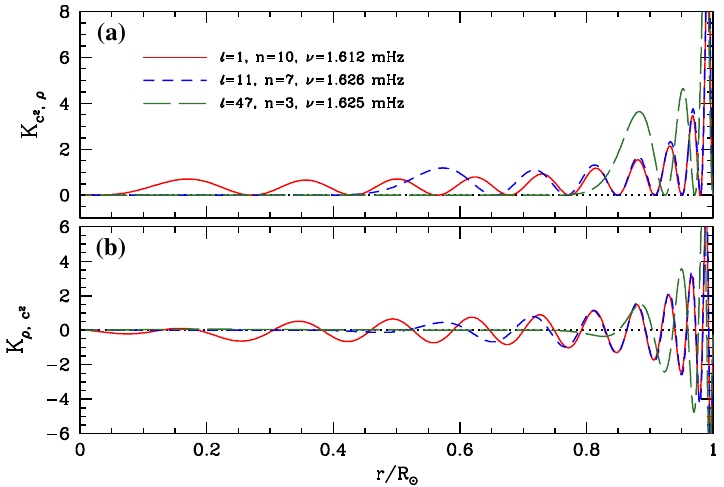
Fig. 11 Sound-speed kernels ( a ) and density ( b ) for modes of different degrees but similar frequencies. Note that modes of lower degrees penetrate deeper than modes of higher degrees